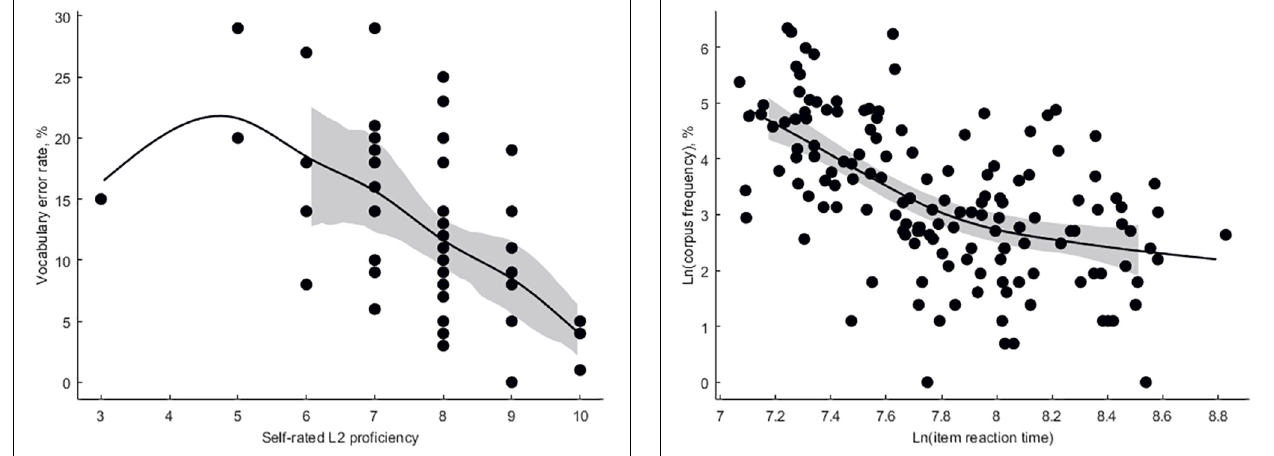
FIGURE 5 | The log-transformed item corpus frequency as a function of the log-transformed item reaction time in the vocabulary task (Eilers smoothing).